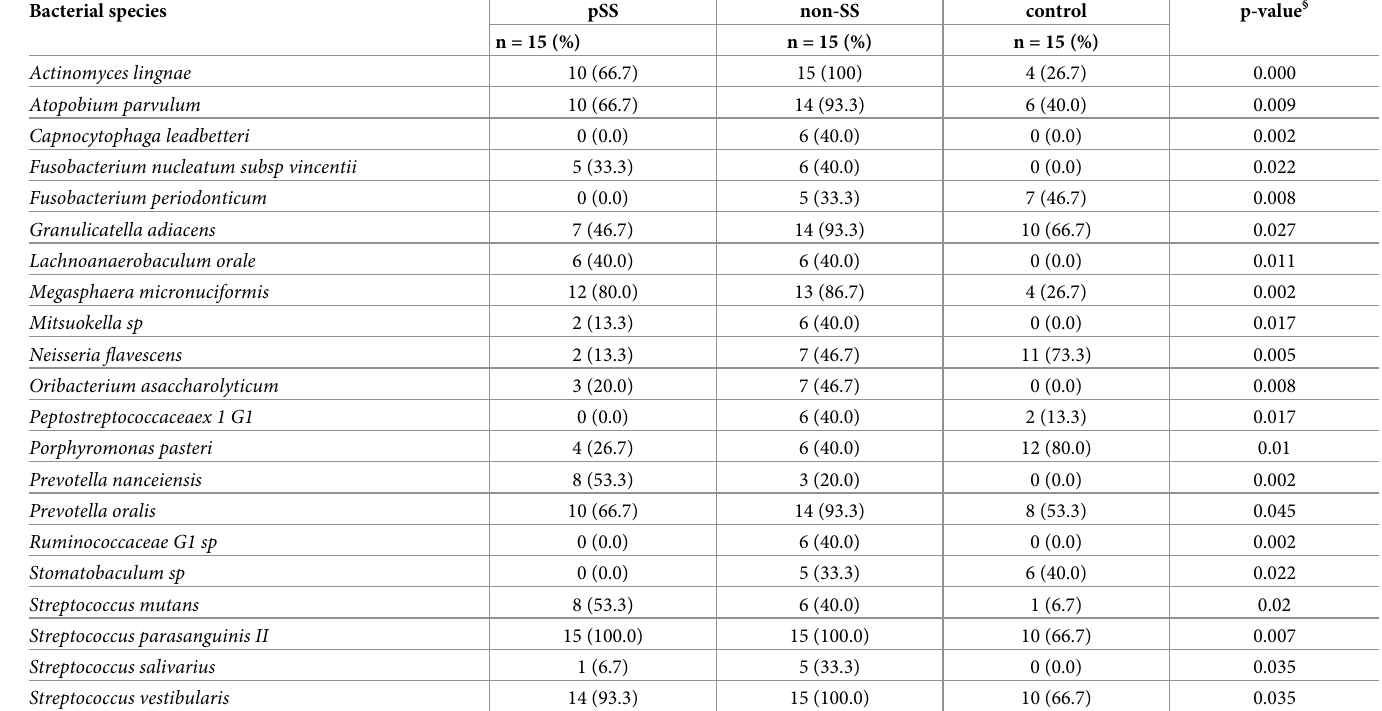
Table 3. Significant different species profiles between